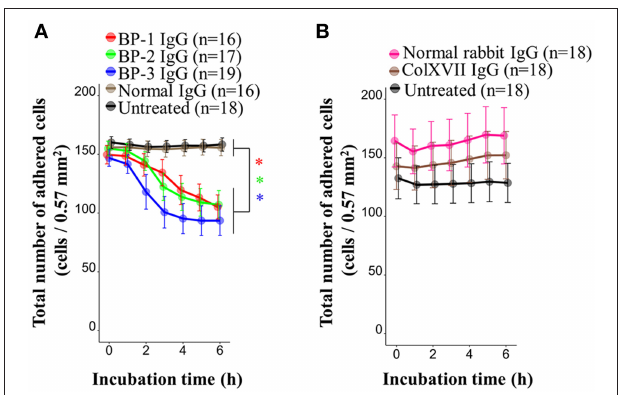
FIGURE 3 | Kinetics of the numbers of adherent NHEKs stimulated with BP IgG. Total numbers of adherent cells after stimulation with (A) BP IgGs, normal IgG, or (B) ColXVII IgG or normal rabbit IgG. The cell numbers were counted hourly in a × 20 area (0.57 mm 2 ) for up to 6h. Two-way ANOVA was used to determine the significance of differences induced by BP IgGs. * p -value <